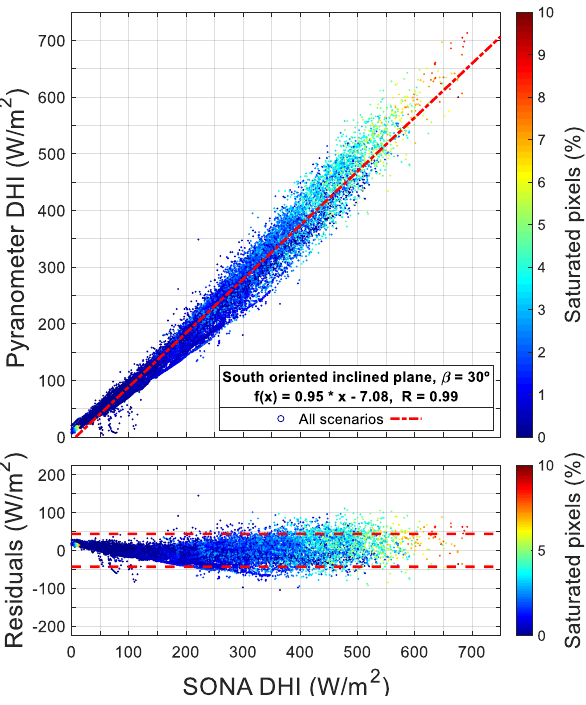
Figure 13. Comparison of the Pyranometer DHI on a 30° tilted plane oriented to South and the DHI retrieval from 4 to 5 September 2021. The samples are gradated according to their percentage of saturated pixels. f(x) is the fit function, represented by the red colored line. Two red dashed lines represent the 95% confidence interval of the residuals.